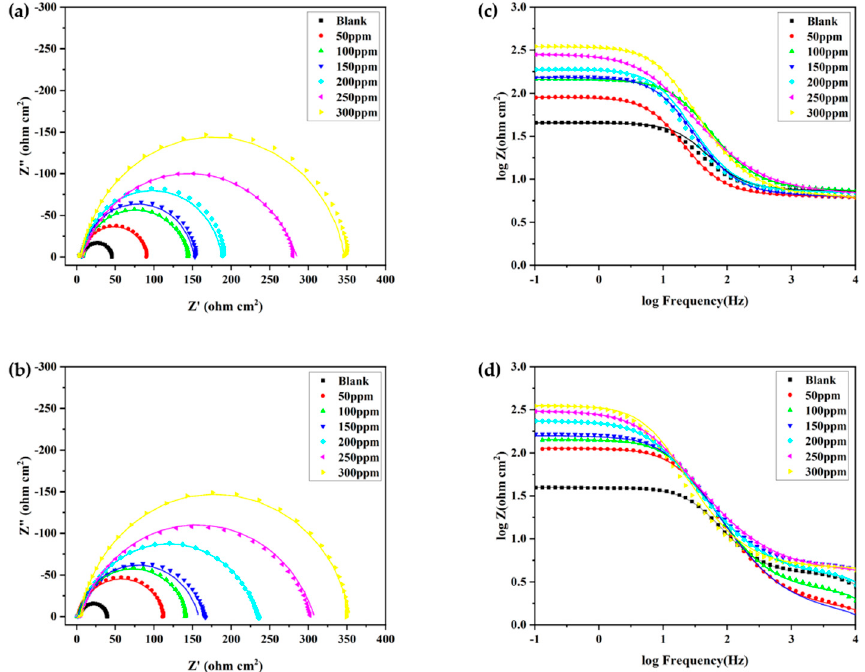
Figure 5. Nyquist ( a ) MPO, ( b ) MPPO and Bode ( c ) MPO, ( d ) MPPO plots of EIS measurements of N80 steel in 1 M HCl without and with different concentrations of inhibitors (characteristic symbol and real line represent experimental results and fitting results, respectively).